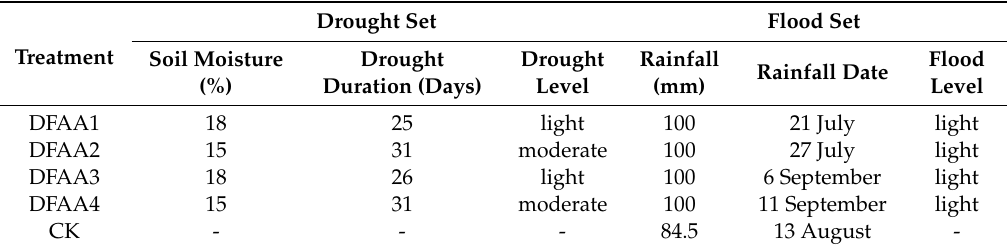
Table 1. Drought and flood sets in different experimental treatments.